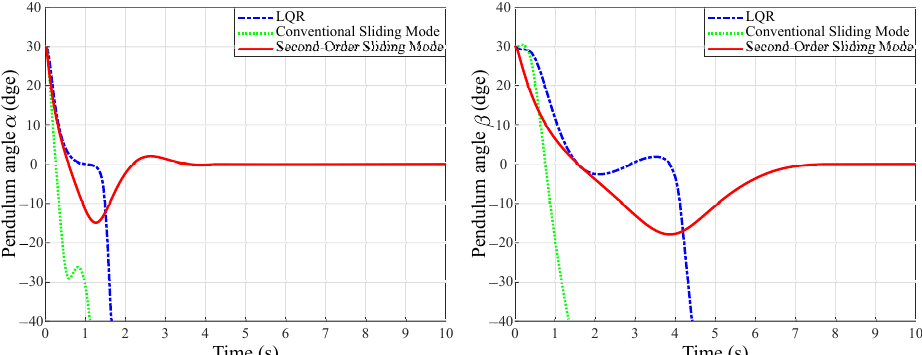
Figure 16. The simulation results for the pendulum’s angle with the initial value of 30 ◦ compare the angle responses of the inverted pendulum on α and β ,